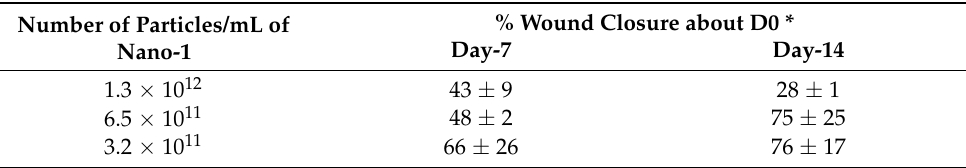
Figure 6. Confocal microscopy of human skin cross ‐ sections treated for 1 h with Nano ‐ 1 ( A ) and Nano ‐ 2 ( B ). The green coloration is BODIPY marker’s distribution indicative in the different skin strata: stratum corneum (SC), viable epidermis (VE), and dermis (D). The left panel represents the bright field. Table 6. Wound closure percentage as a function of the number of Nano-1 particles applied and treatment time. n = 3